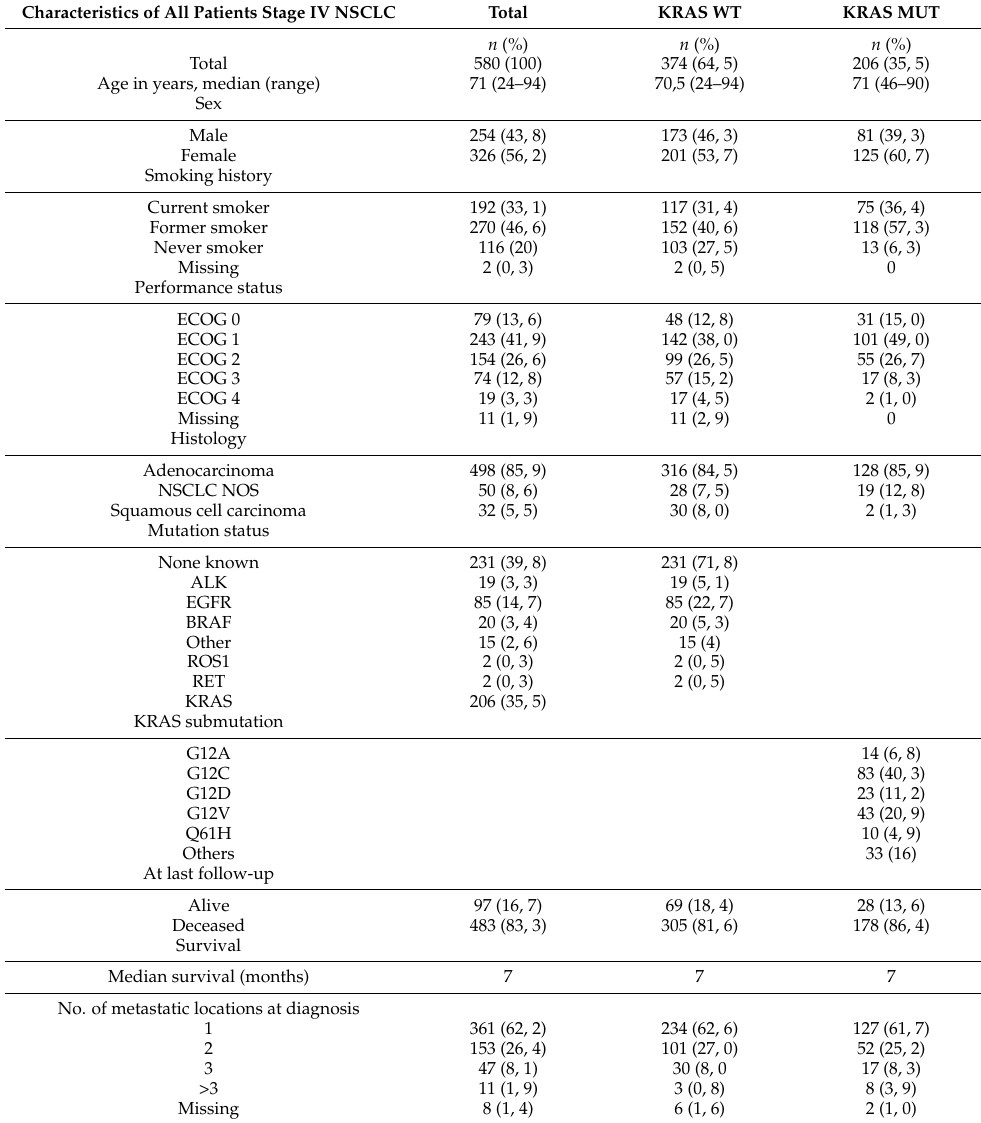
Table 1. Characteristics of the total cohort as well as stratified on KRAS WT and KRAS MUT . Data are presented as n